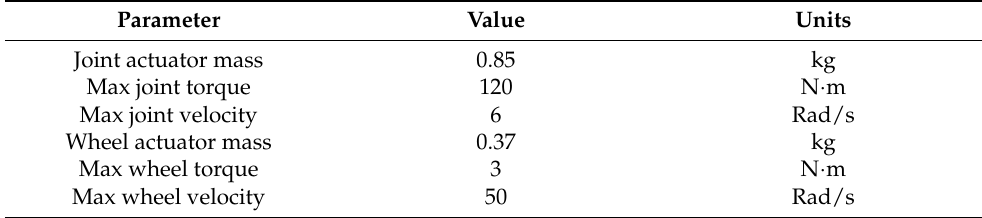
Table 3. Actuator parameters.